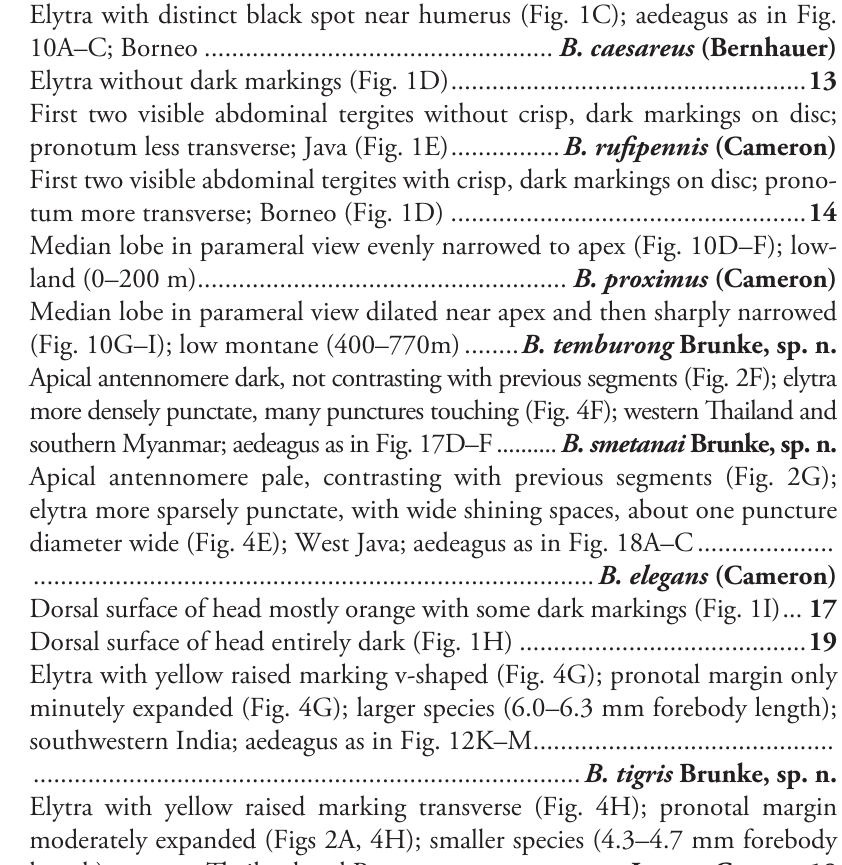
Elytra with distinct black spot near humerus (Fig. 1C); aedeagus as in Fig. – Elytra without dark markings (Fig. 1D) .................................................... 13 13 First two visible abdominal tergites without crisp, dark markings on disc; pronotum less transverse; Java (Fig. 1E) ................ B. rufipennis (Cameron) – First two visible abdominal tergites with crisp, dark markings on disc; prono- tum more transverse; Borneo (Fig. 1D) .................................................... 14 14 Median lobe in parameral view evenly narrowed to apex (Fig. 10D–F); low- land (0–200 m) ...................................................... B. proximus (Cameron) – Median lobe in parameral view dilated near apex and then sharply narrowed (Fig. 10G–I); low montane (400–770m) ........ B. temburong Brunke, sp. n. 15 Apical antennomere dark, not contrasting with previous segments (Fig. 2F); elytra more densely punctate, many punctures touching (Fig. 4F); western Thailand and southern Myanmar; aedeagus as in Fig. 17D–F .......... B. smetanai Brunke, sp. n. – Apical antennomere pale, contrasting with previous segments (Fig. 2G); elytra more sparsely punctate, with wide shining spaces, about one puncture diameter wide (Fig. 4E); West Java; aedeagus as in Fig. 18A–C .................... 16 Dorsal surface of head mostly orange with some dark markings (Fig. 1I) ... 17 – Dorsal surface of head entirely dark (Fig. 1H) .......................................... 19 17 Elytra with yellow raised marking v-shaped (Fig. 4G); pronotal margin only minutely expanded (Fig. 4G); larger species (6.0–6.3 mm forebody length); southwestern India; aedeagus as in Fig. 12K–M ............................................ – Elytra with yellow raised marking transverse (Fig. 4H); pronotal margin moderately expanded (Figs 2A, 4H); smaller species (4.3–4.7 mm forebody length); western Thailand and Borneo ............................ Luteus Group ... 18 18 Abdominal tergites IV–V each with strongly impressed and elongate punc- tures in basal impression (Fig. 5A); apical three antennomeres pale, contrast- ing with previous segments (Fig. 2A); Borneo; aedeagus as in Fig. 13E–G .... ............................................................................. B. sepilok Brunke, sp. n. – Abdominal tergites IV–V each with typical circular punctures; only apical antennomere distinctly paler than previous segments (Fig. 4I); western Thai- land; aedeagus as in Fig. 13A–D ............................. B. luteus Brunke, sp. n. 19 Pronotal margin greatly expanded, at its widest point, more than four lateral puncture widths wide (Figs 1G, 4C) ............................. Carnifex group ... 20 – Pronotal margin slightly to moderately expanded, at its widest point, no more than three lateral puncture widths wide (Figs 2B, 4D) ..................... 26 20 Base of elytra distinctly darker than rest of disc (Fig. 1G); Meghalaya, India; aedeagus as in Fig. 12D–G ................................... B. nokrek Brunke, sp. n. – Disc of elytra entirely reddish (except for pale markings) (as in Fig.